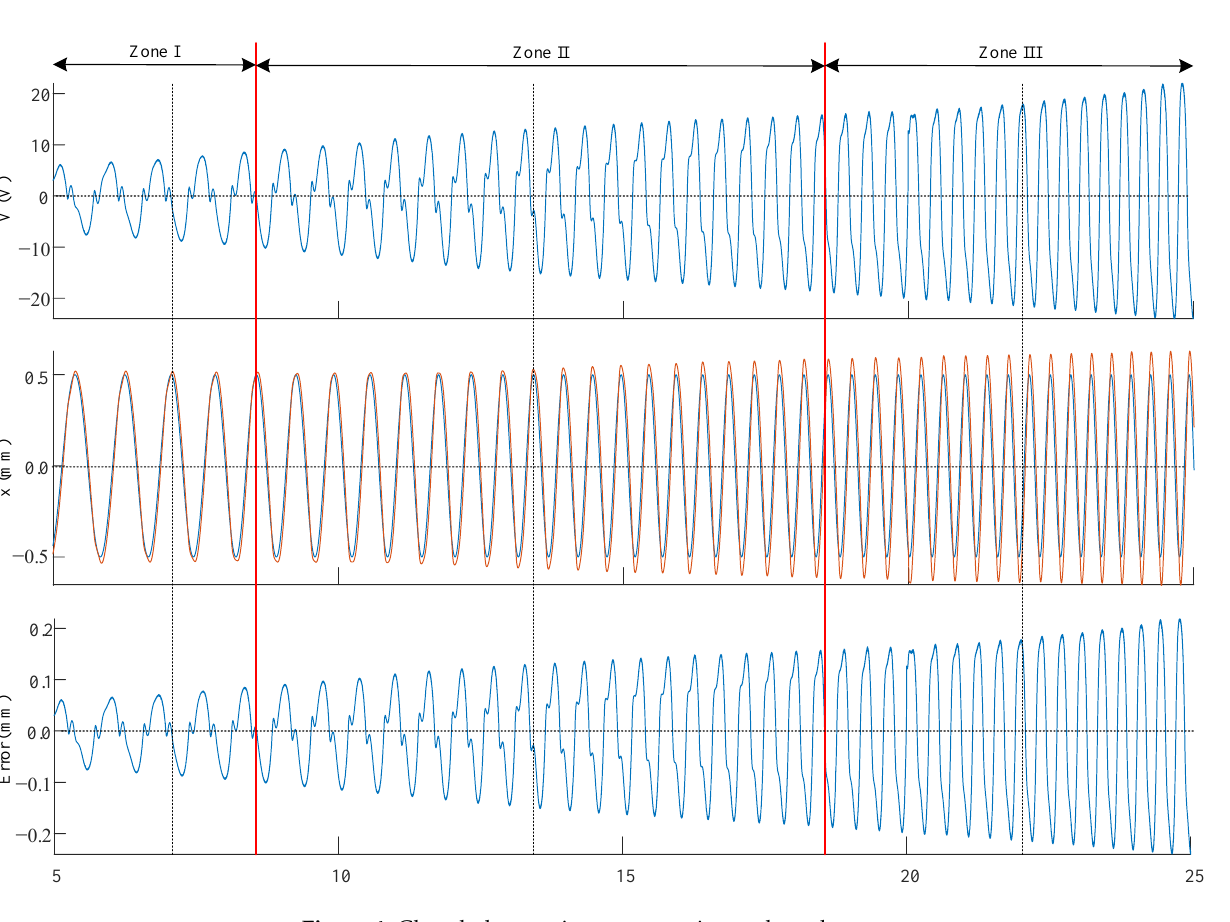
Figure 4. Closed − loop trajectory: experimental results.